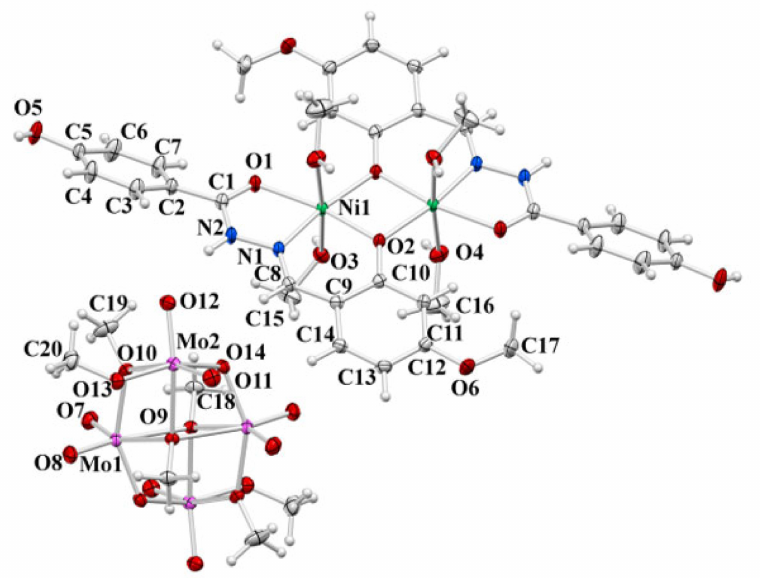
Figure 7. ORTEP view of molecular structure of 10 . The displacement ellipsoids are drawn at the 50% probability level at 150(2) K. The hydrogen atoms are drawn as spheres of arbitrary radius. The atom-numbering crystallographic scheme has been